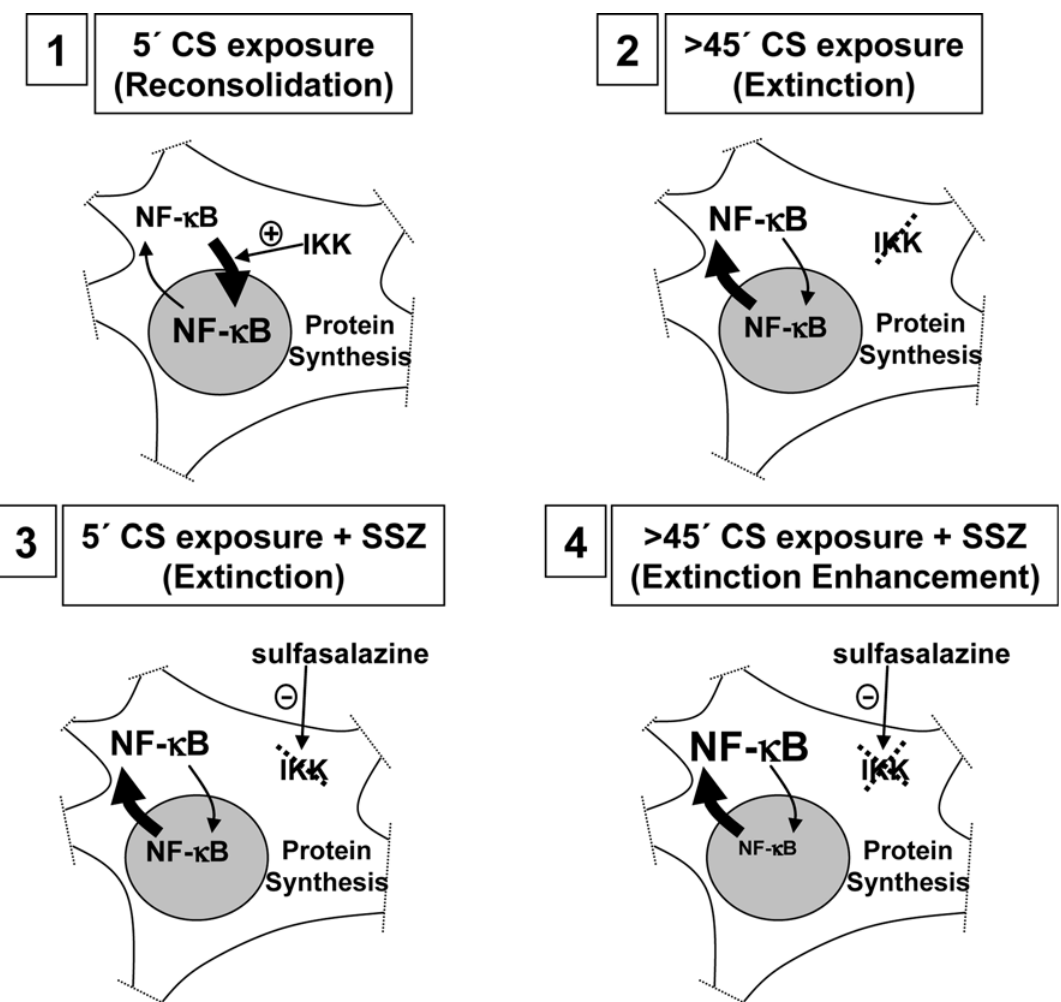
Figure 8. A model of NF- k B role in memory extinction and reconsolidation, and the effect of its inhibition. 1) Five min context re- exposure induces NF- k B-dependent and protein synthesis-dependent memory reconsolidation. 2) Prolonged re-exposure induces NF- k B inhibition and protein synthesis-dependent memory extinction. 3) NF- k B inhibition by sulfasalazine plus 5 min re-exposure mimics memory extinction. 4) NF- k B inhibition by sulfasalazine plus prolonged re-exposure induces extinction